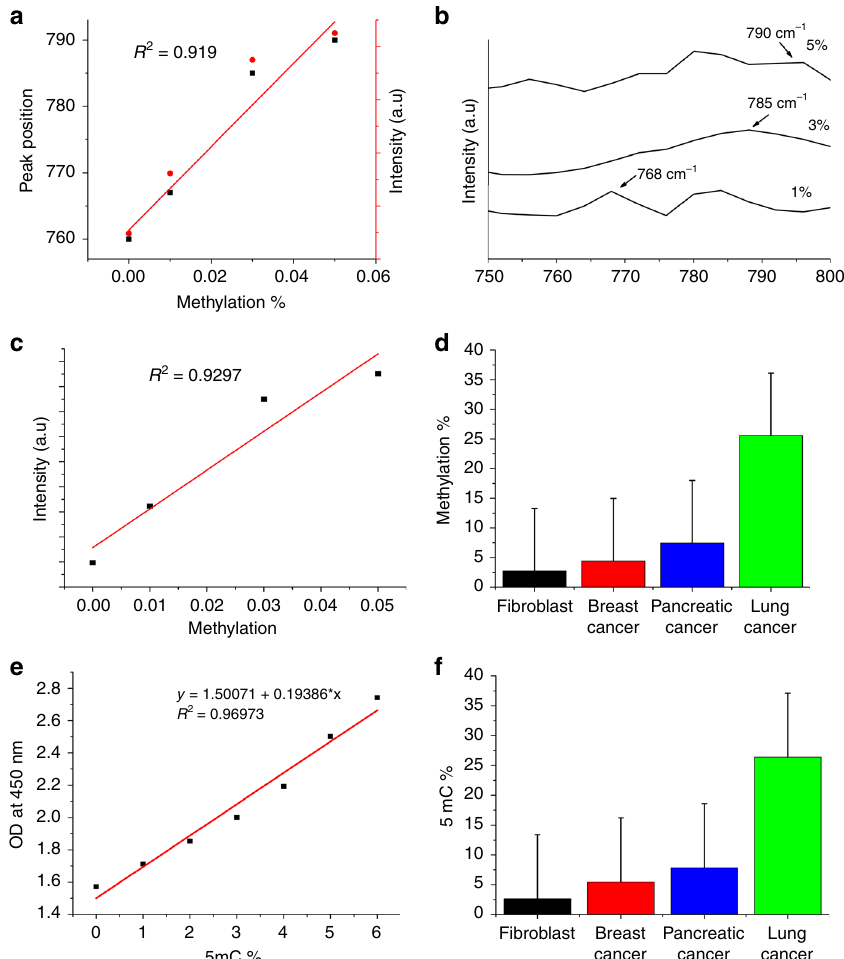
Fig. 7 Quanti fi cation of global DNA hypermethylation using SERS. a SERS spectra of 5mC DNA with different methylation percentages. b Standard curve based on peak position and SERS intensity for quanti fi cation of DNA methylation. c Standard curve based on peak intensity for quanti fi cation of DNA methylation. d Percentage DNA methylation obtained through QOS-based SERS. Validation of SERS based DNA methylation with colorimetric assay. e Standard curve based on OD at 450 nm. f Percentage DNA methylation based on colorimetric